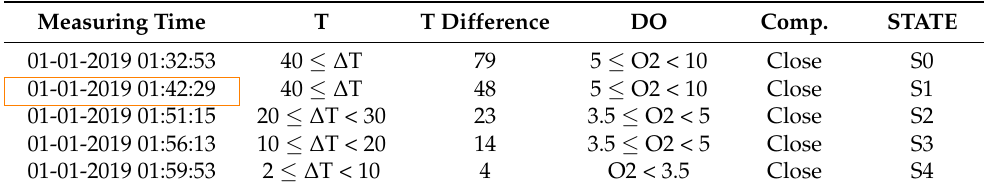
Table 5. Example of heat’s state format after discretisation. Measuring Time T T Difference